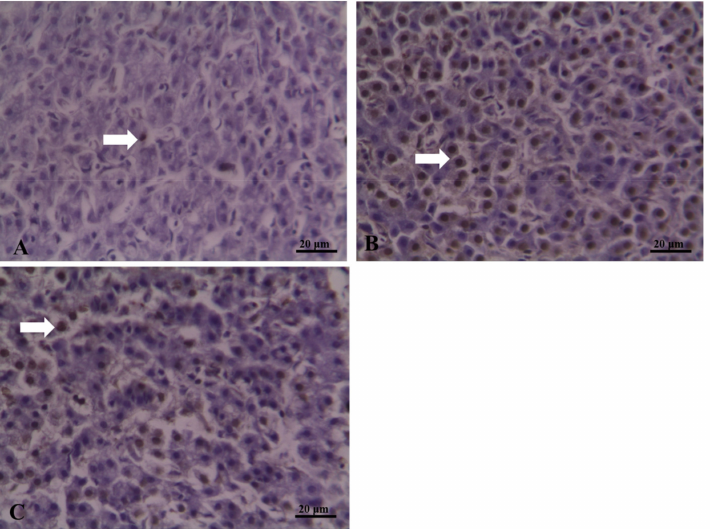
Figure 3. Hepatocyte apoptosis in blunt Snout Bream: ( A ) normal cells (stained amethyst) and apoptotic cells (white arrow) from LFD group; ( B ) normal cells and apoptotic cells from HFD group; ( C ) normal cells and apoptotic cells from the HFD+HT group.